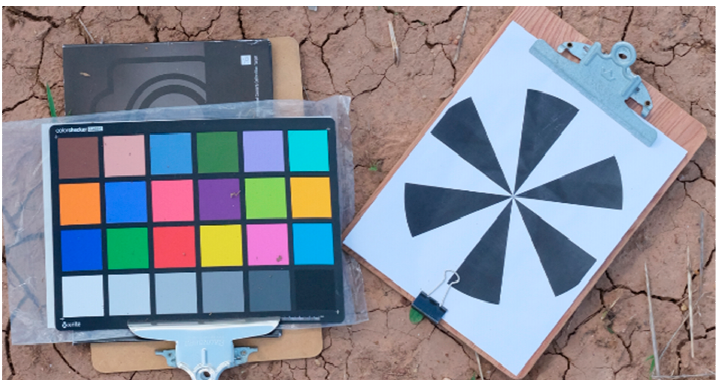
Figure 3. An example of the ColorChecker and the slant edge landmark image taken by the camera before data collection in the field, for estimating color transformation matrix M and point spread function (PSF).